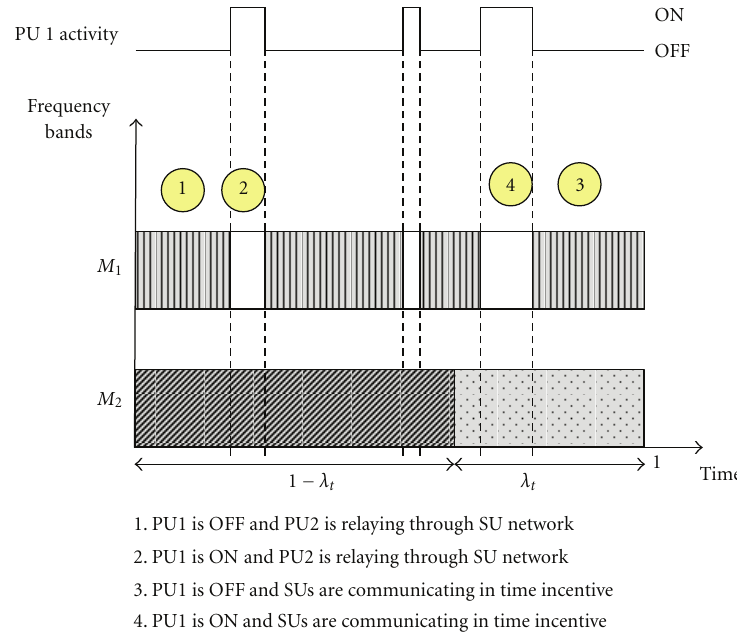
Figure 3: SS-SCR scheme.